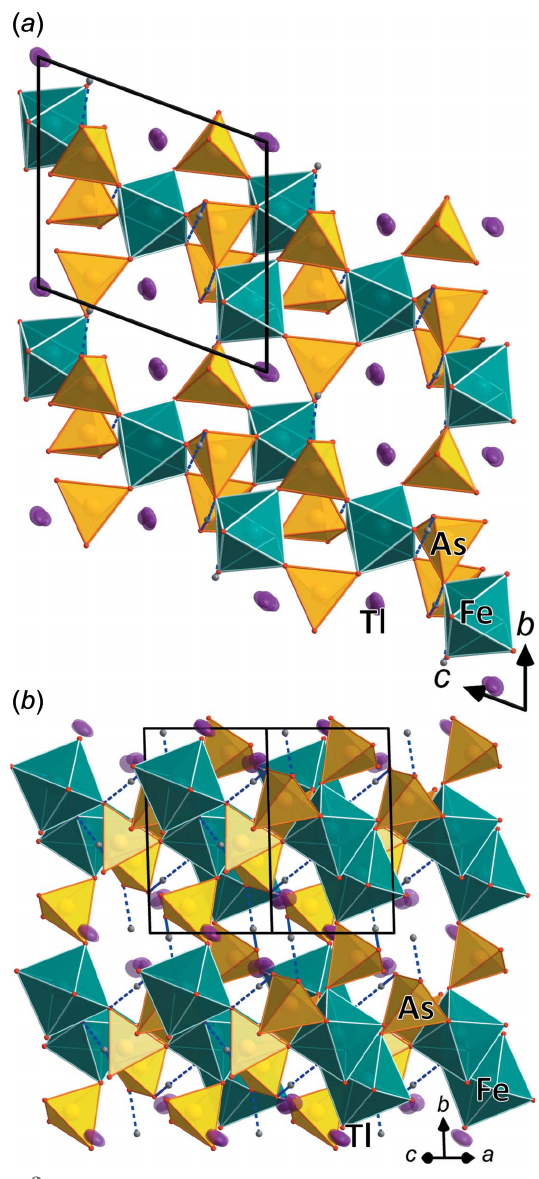
Figure 3 Structure drawing of TlFe(HAsO 4 ) 2 along ( a ) [100] and ( b ) [101]. The disordered Tl atoms are shown with displacement ellipsoids at the 70% probability level. Hydrogen bonds are shown as dashed